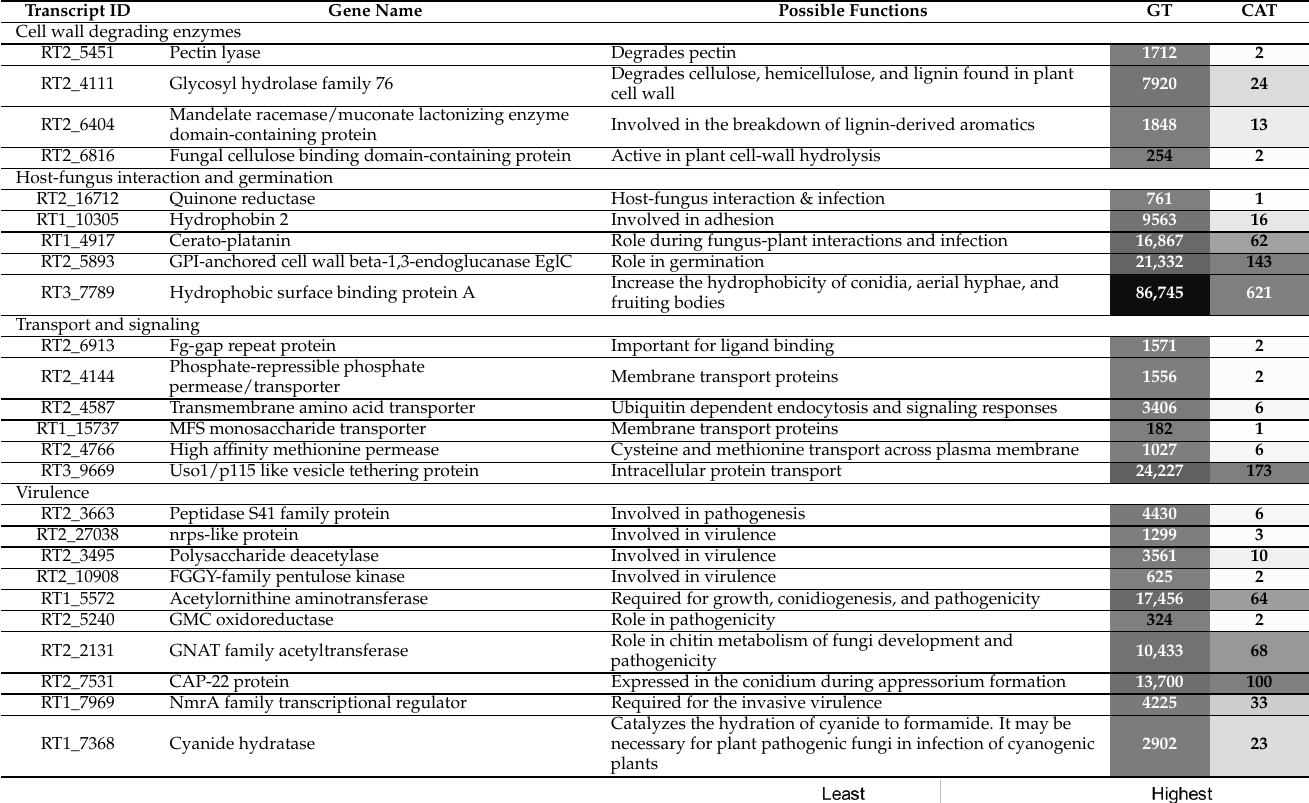
Table 1. Selected upregulated genes during GT formation showing their possible functions and respective expression values in GT and CAT in C. gloeosporioides .